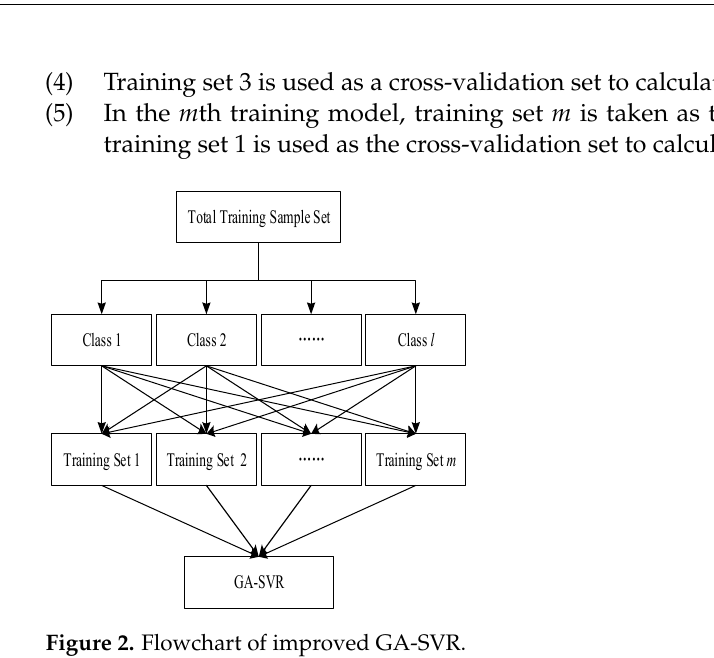
Figure 2. Flowchart of improved GA-SVR.